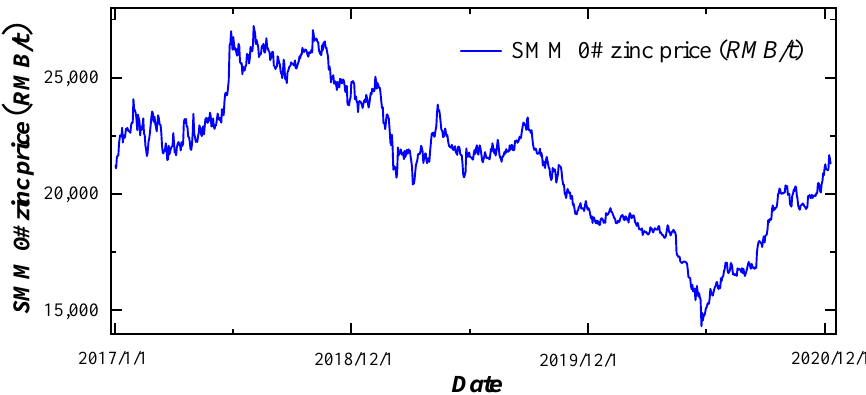
Figure 4. The 0# zinc price of Shanghai Metal Market from 3 January 2017 to 2 December 2020. Table 1. Abbreviations of collected